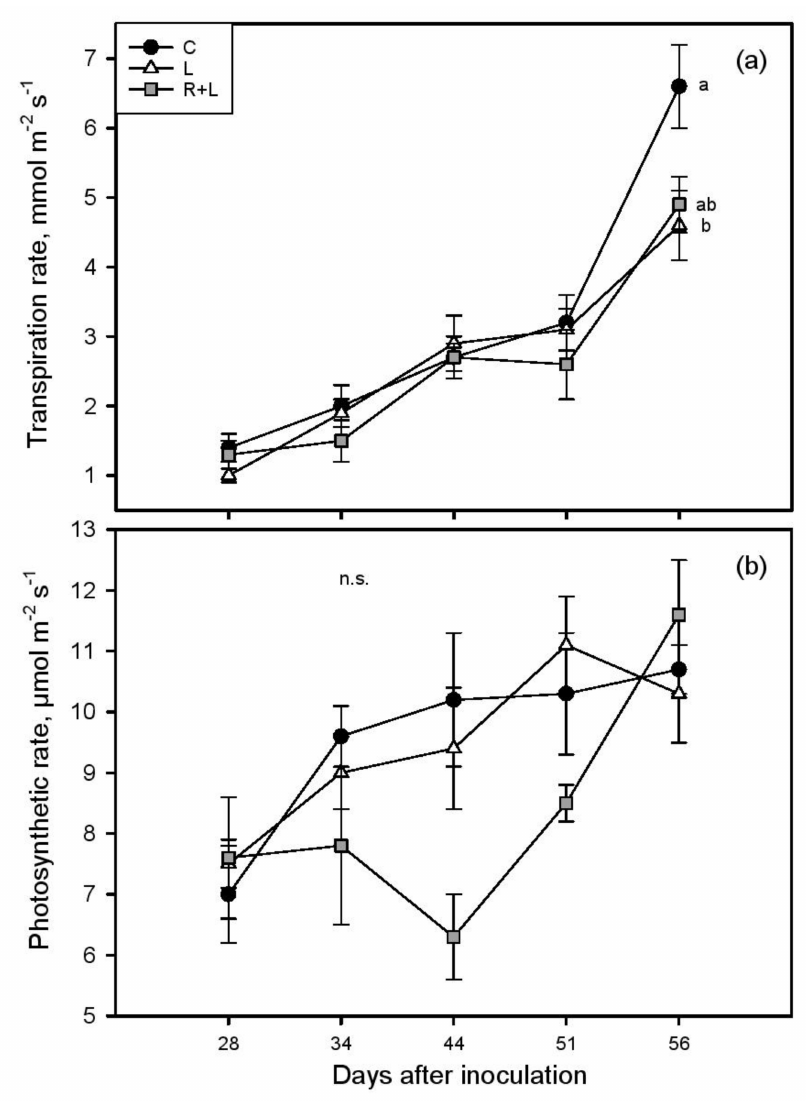
Figure 1. Transpiration (E L ) ( a ) and photosynthetic (A) ( b ) rates as measured in control (C, closed circles), leaf infested (L, open triangles), and both root and leaf infested (R + L, grey squares) plants during the treatment application (n = 5–8). Different letters denote significant differences among groups; n.s. indicates lack of statistically significant